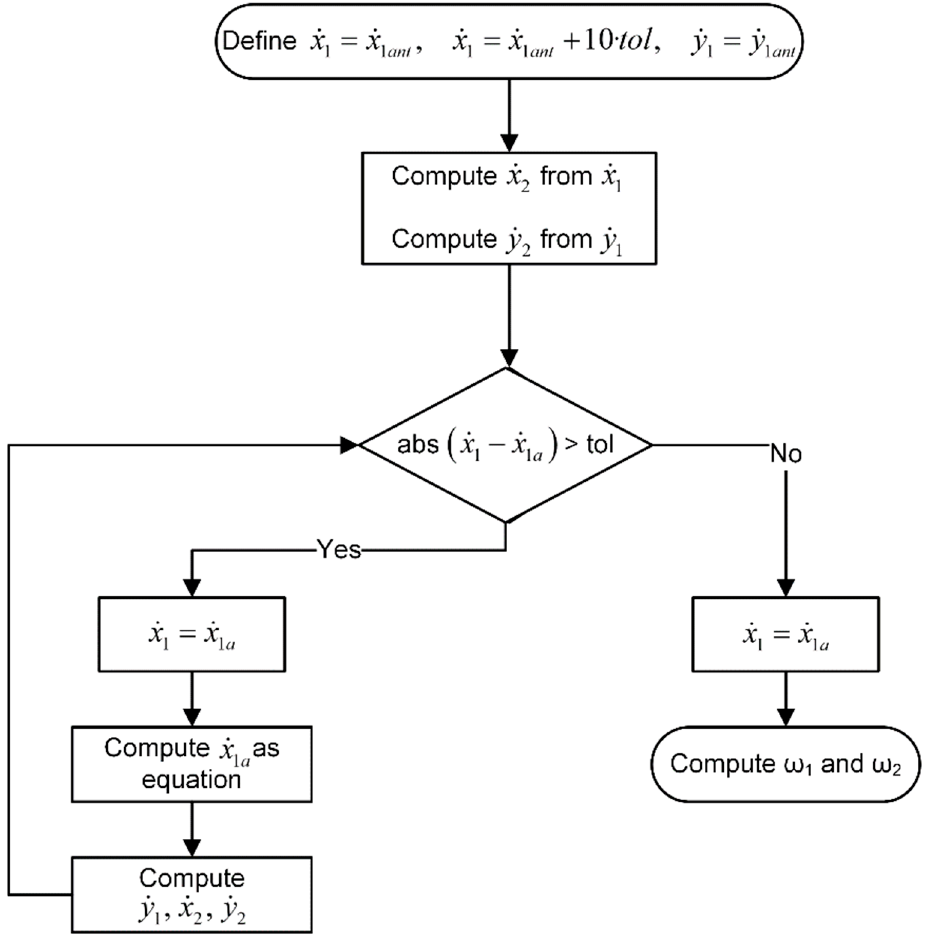
Figure 2. Flowchart for computing the angular speeds. Two different ground topographies and several values of the parameter D were pro ‐ posed for testing the algorithm. The first topography (profile 1) simulates a wiggly surface and is defined by Equation (13)—where A 1 is the amplitude of the wave and λ 1 is the wavelength, both in meters.